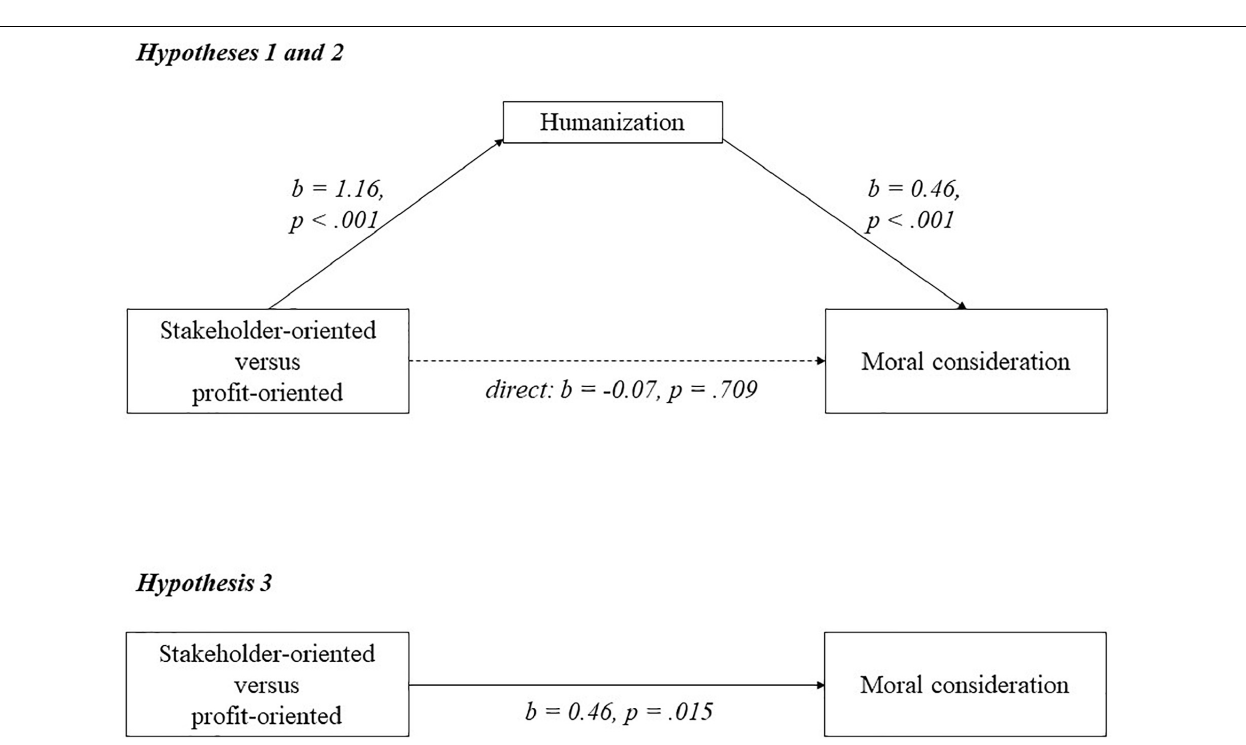
Frontiers in Psychology |